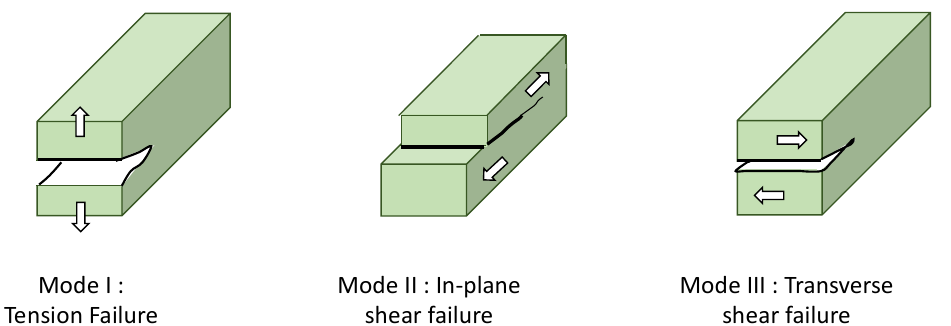
Figure 4. The different loading modes applied at the micro-scale leading to the failure of the materials according to Karinkanta [44].